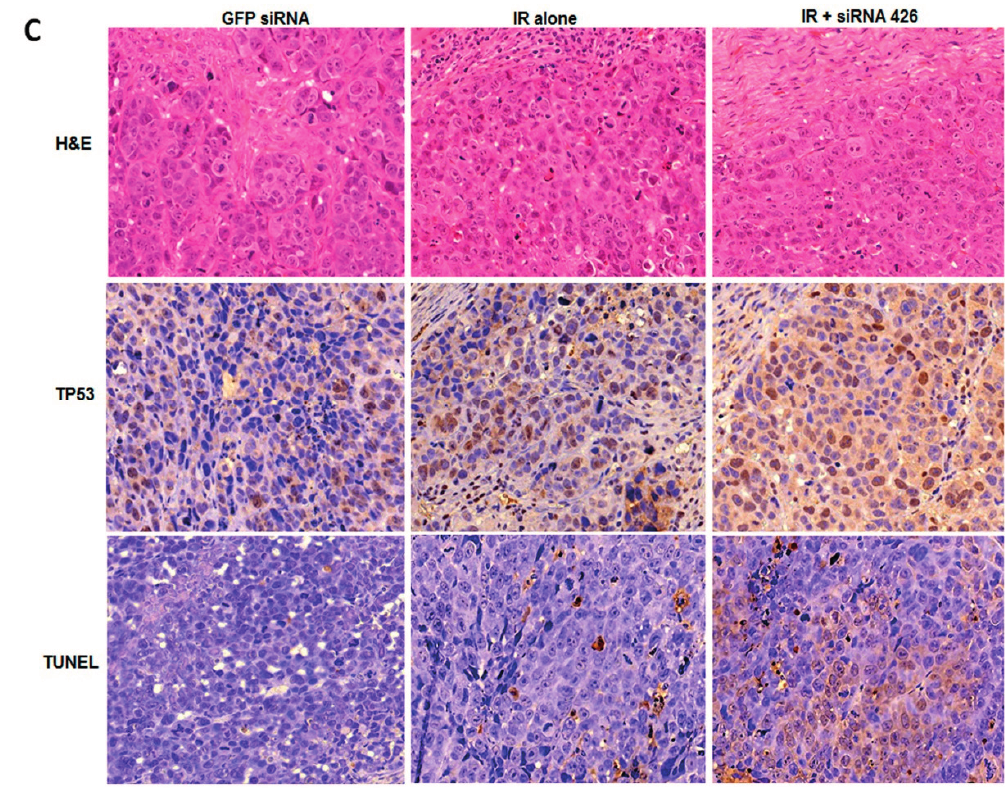
Figure 2. In vivo therapeutic effect of E6/E7-specific siRNAs in combination with radiation in human cervical cancer xenografted mice. ( A ) Treatment protocol; and ( B ) Luciferase activity was measured in live mice using the Luminescence Animal Imaging System, and tumor images were taken after 19 days. Untreated or control GFP-specific siRNA-treated mice served as controls. * p = 0.016 at Day 19, compared with γ -irradiation alone; and ( C ) H&E staining (×400), TP53 (×400) and TUNEL immunohistochemical (IHC) (×400) analysis on Day